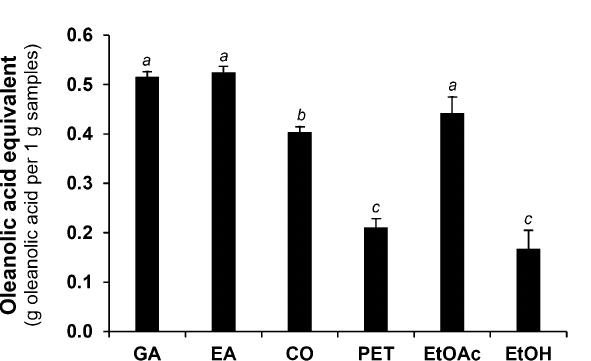
Figure 2. Oleanolic acid equivalent on hyaluronidase inhibition of gallic acid (GA), ellagic acid (EA), corilagin (CO), and black D. longan seed extracts, extracted using petroleum ether (PET), ethyl acetate (EtOAc), and 95% v / v ethanol (EtOH). Different letters, a, b, and c, denote a statistically significant difference in oleanolic acid equivalents among samples ( p <